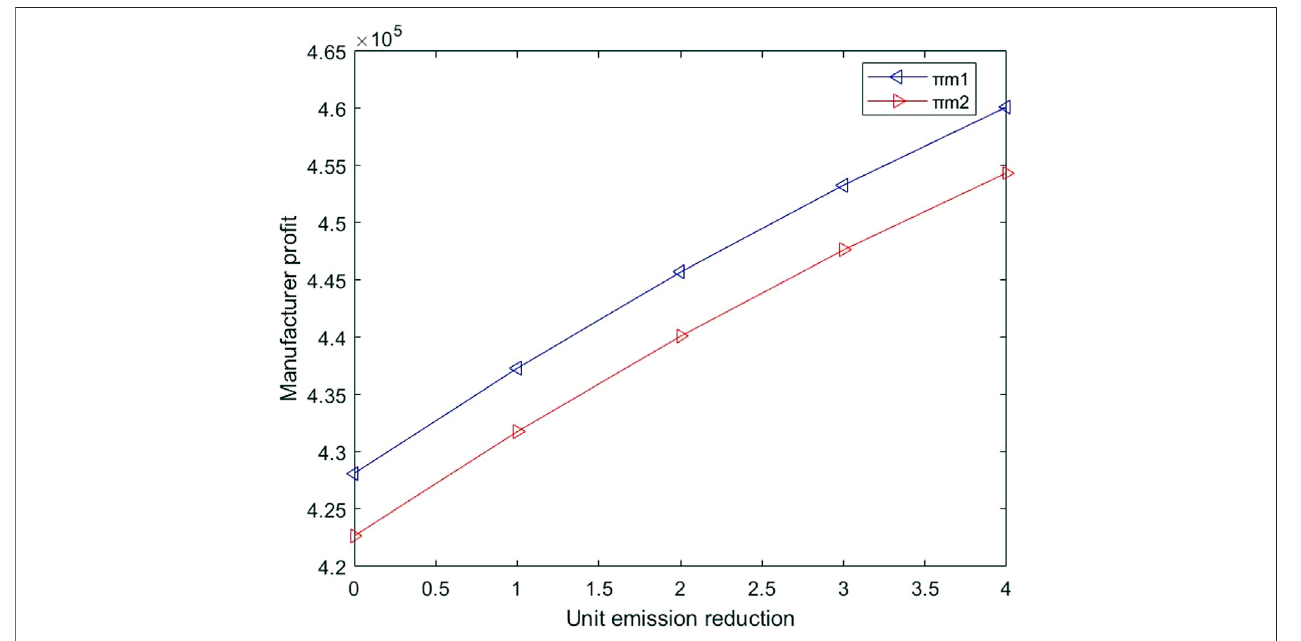
FIGURE 10 | Manufacturer ’ s pro fi t comparison